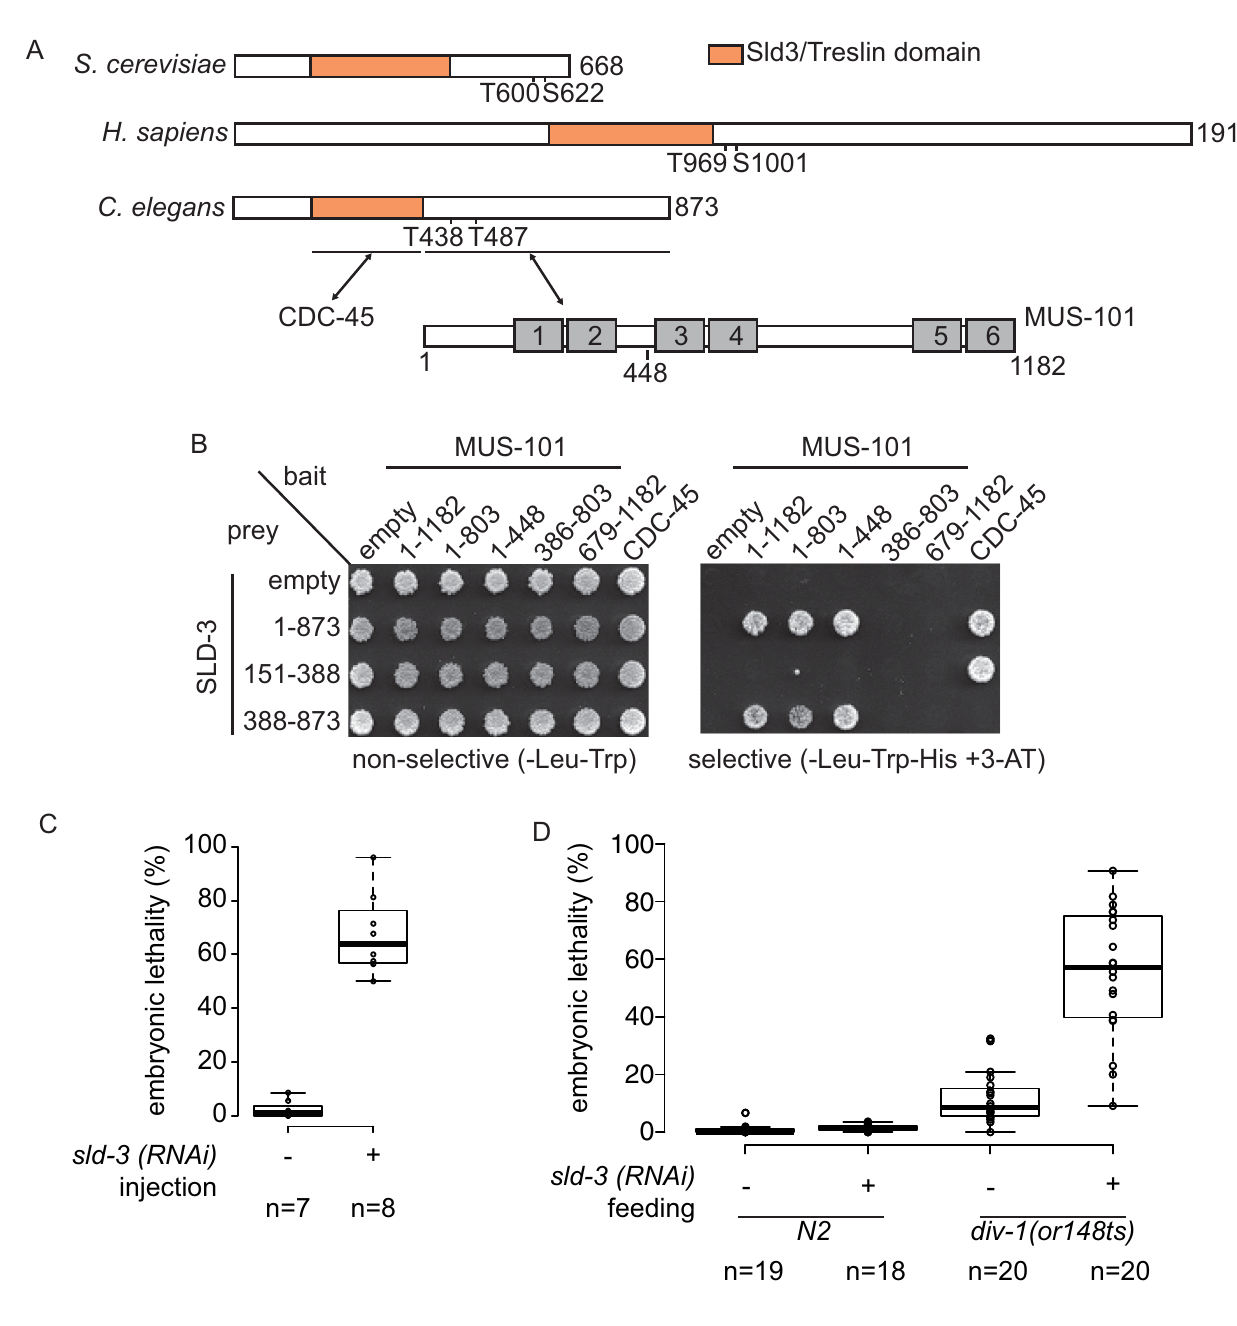
Fig 1. ZK484.4 is C . elegans sld-3 A. Scale diagram of Sld3, Treslin and ZK484.4 from budding yeast, humans and C . elegans respectively. The Cdc45 interaction (Sld3/Treslin) domain is in orange. The essential CDK sites in Sld3/Treslin and their potential orthologues in C . elegans are numbered. The regions of interaction between C . elegans ZK484.4 and CDC-45/MUS-101 are indicated below, together with a scale diagram of MUS-101 showing the 6 BRCT repeats as grey boxes. B. Yeast two-hybrid analysis between MUS-101 and CDC-45 bait constructs and SLD-3 prey on non-selective (-Leu-Trp) and selective medium (-Leu-Trp-His+3-AT). C. Box and whisker plot of embryonic lethality with and without sld-3 RNAi by injection. n refers to the number of mothers analysed. D. As C except RNAi was performed by feeding at 21˚C.